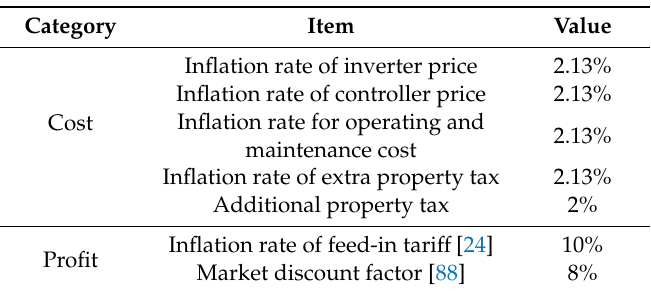
Table 13. Economic